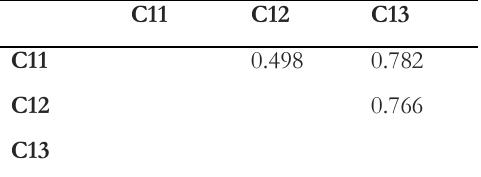
Table 4. Pairwise comparisons of export marketing sub-criteria.